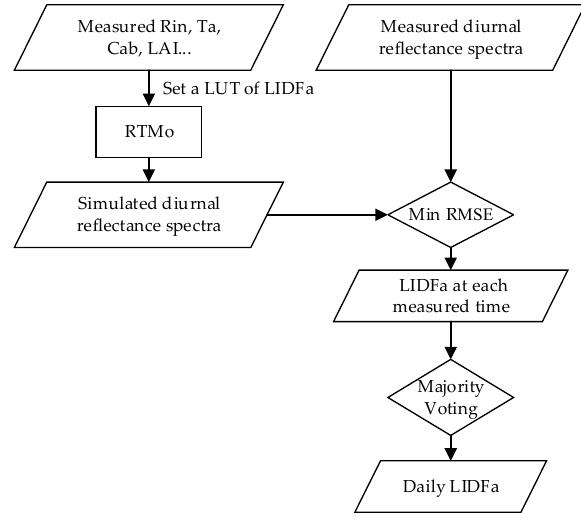
Figure 2. Schematic overview of the LIDFa inversion procedure.